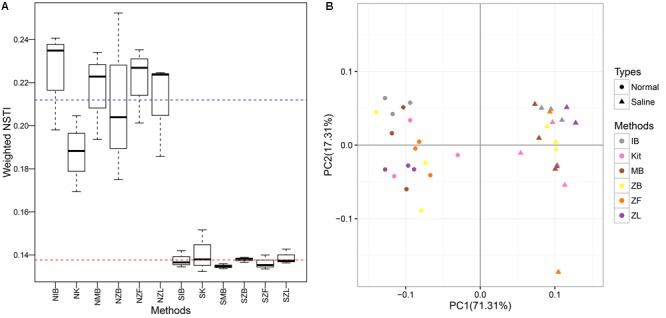
Boxplots of weighted NSTI (Nearest Sequenced Taxon Index) values (A) and PCoA based on the Bray-Curtis distance calculated with the predictive KEGG Orthology table (B). The blue and red dotted line represented the mean of NSTI values in the normal soil and in the saline soil, respectively.